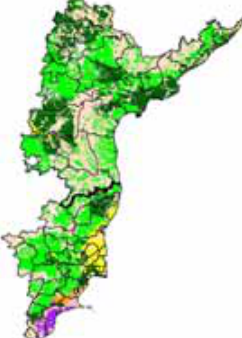
Figure 5: Earliest period of attaining the ACS in different parts of AP and TN during June to November 2010